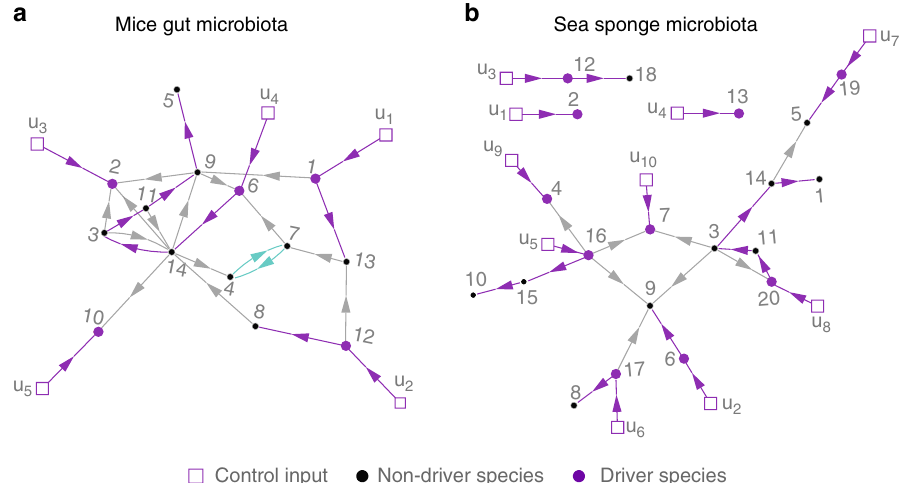
Fig. 3 Identifying driver species. For each network, a minimum set of driver species is shown providing a disjoint union of paths (purple) and cycles (green) covering all species nodes (see Supplementary Table 1 for the species name). Thus, the resulting controlled ecological network is structurally accessible. Self-loops are omitted from these networks to improve readability. a Inferred ecological network of the gut microbiota of germ-free mice pre-colonized with a mixture of human commensal bacterial type strains and then infected with C. dif fi cile (species 7), as in ref. 22 b Inferred ecological network of the core microbiota of the sea sponge Ircinia oros , as in ref.